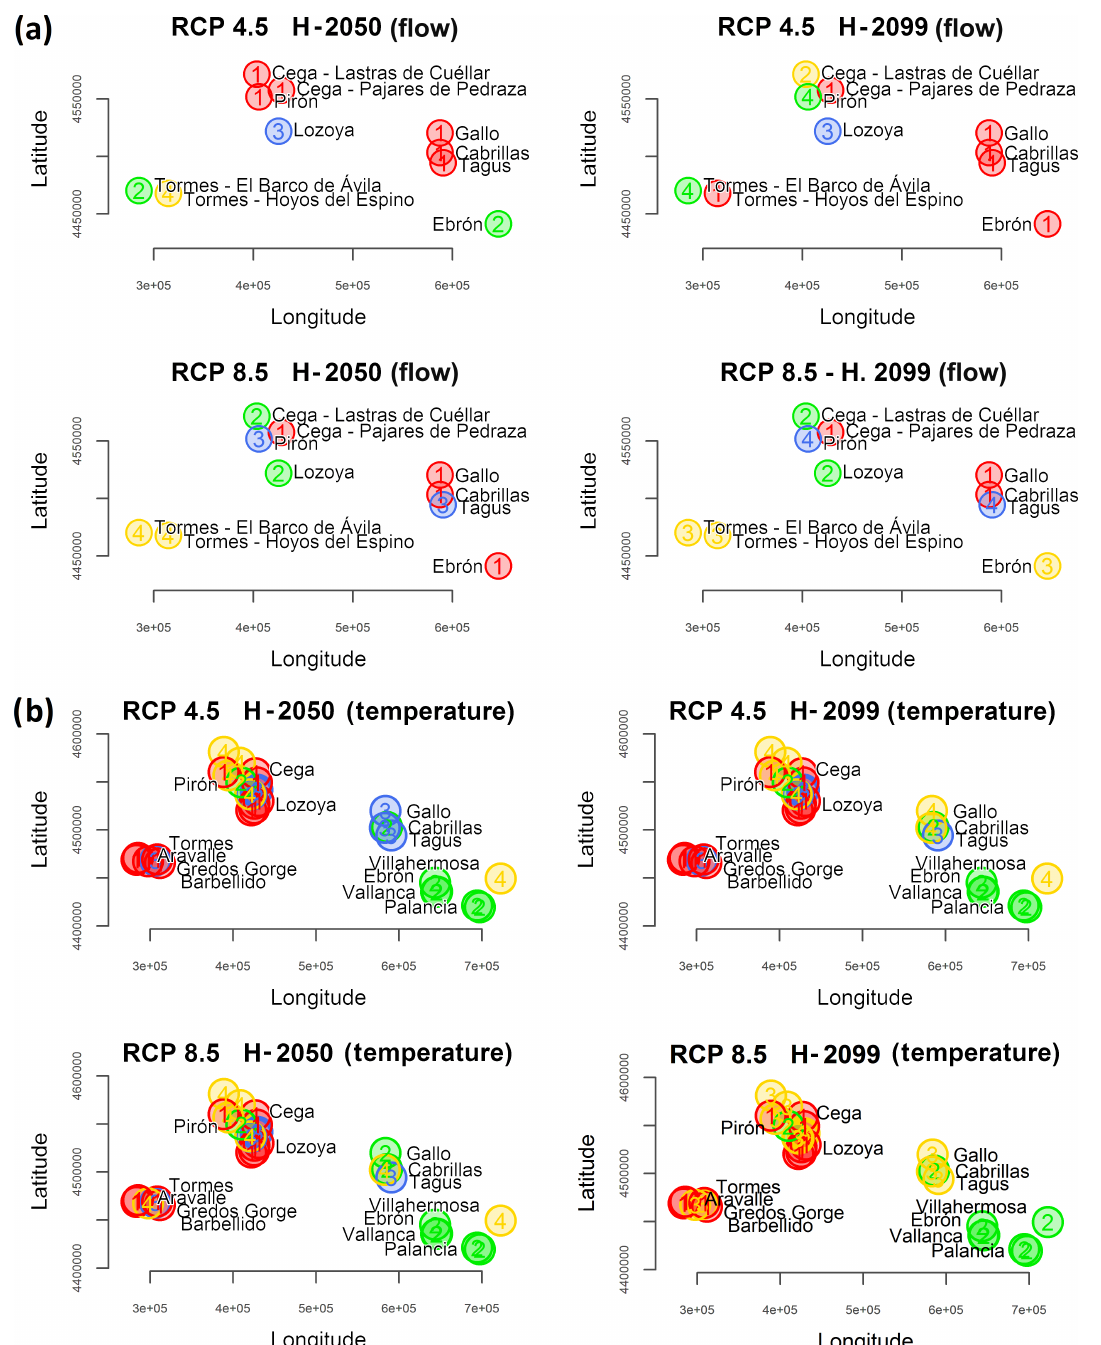
Figure 7. Study sites clustered by the predicted change ratios of the seasonal mean streamflow (gauging stations) and by the predicted increase in the monthly mean stream temperature ( ◦ C) at the water temperature recording sites in H-2050 and H-2099 for the RCP4.5 and RCP8.5 scenarios. Axes indicate geographic positions (UTM coordinates). The colours and numbers indicate the